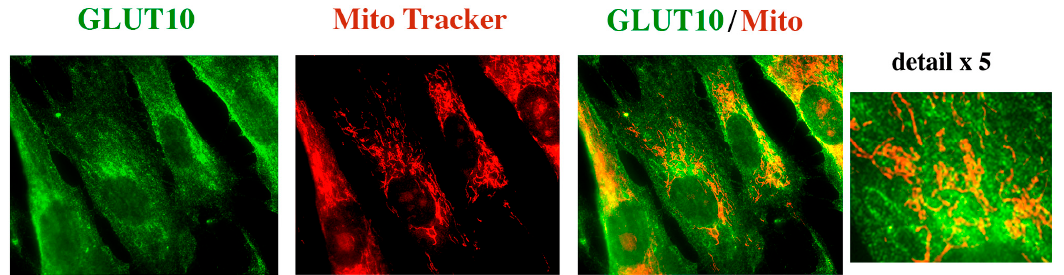
Figure 3. GLUT10 immunostaining and mitochondrial decoration with a fluorescent probe in the human fibroblast cell line BJ-5ta. Human fibroblast immortalized with hTERT (BJ-5ta line) were immunoreacted with the anti-GLUT10 antibody Ab2, and the mitochondrial fluorescent probe Mito Tracker™ Orange as reported in the “Experimental” section. Images were acquired by fluorescent microscopy as detailed in the “Experimental” section. Scale bar = 5 μ m.